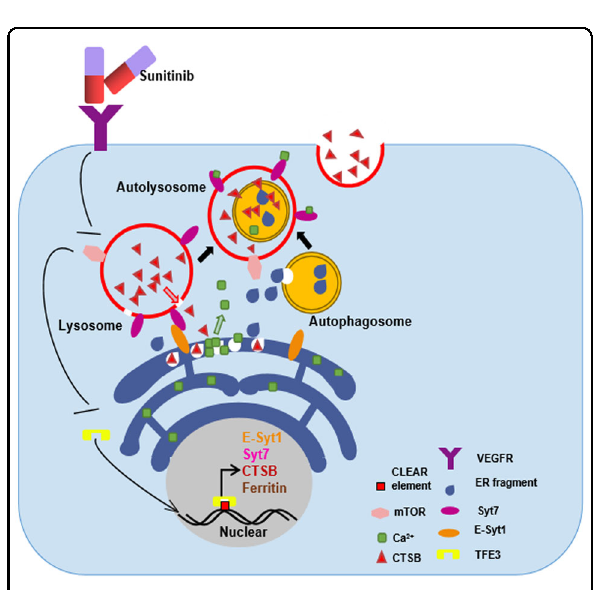
Fig. 7 The schematic illustrates the phenomena and mechanisms described in this paper. Sunitinib stimulated TFE3 to enter the nucleus, which promoted the transcription of a series of genes, and fi nally promoted lysosome exocytosis through ER-phagy and calcium